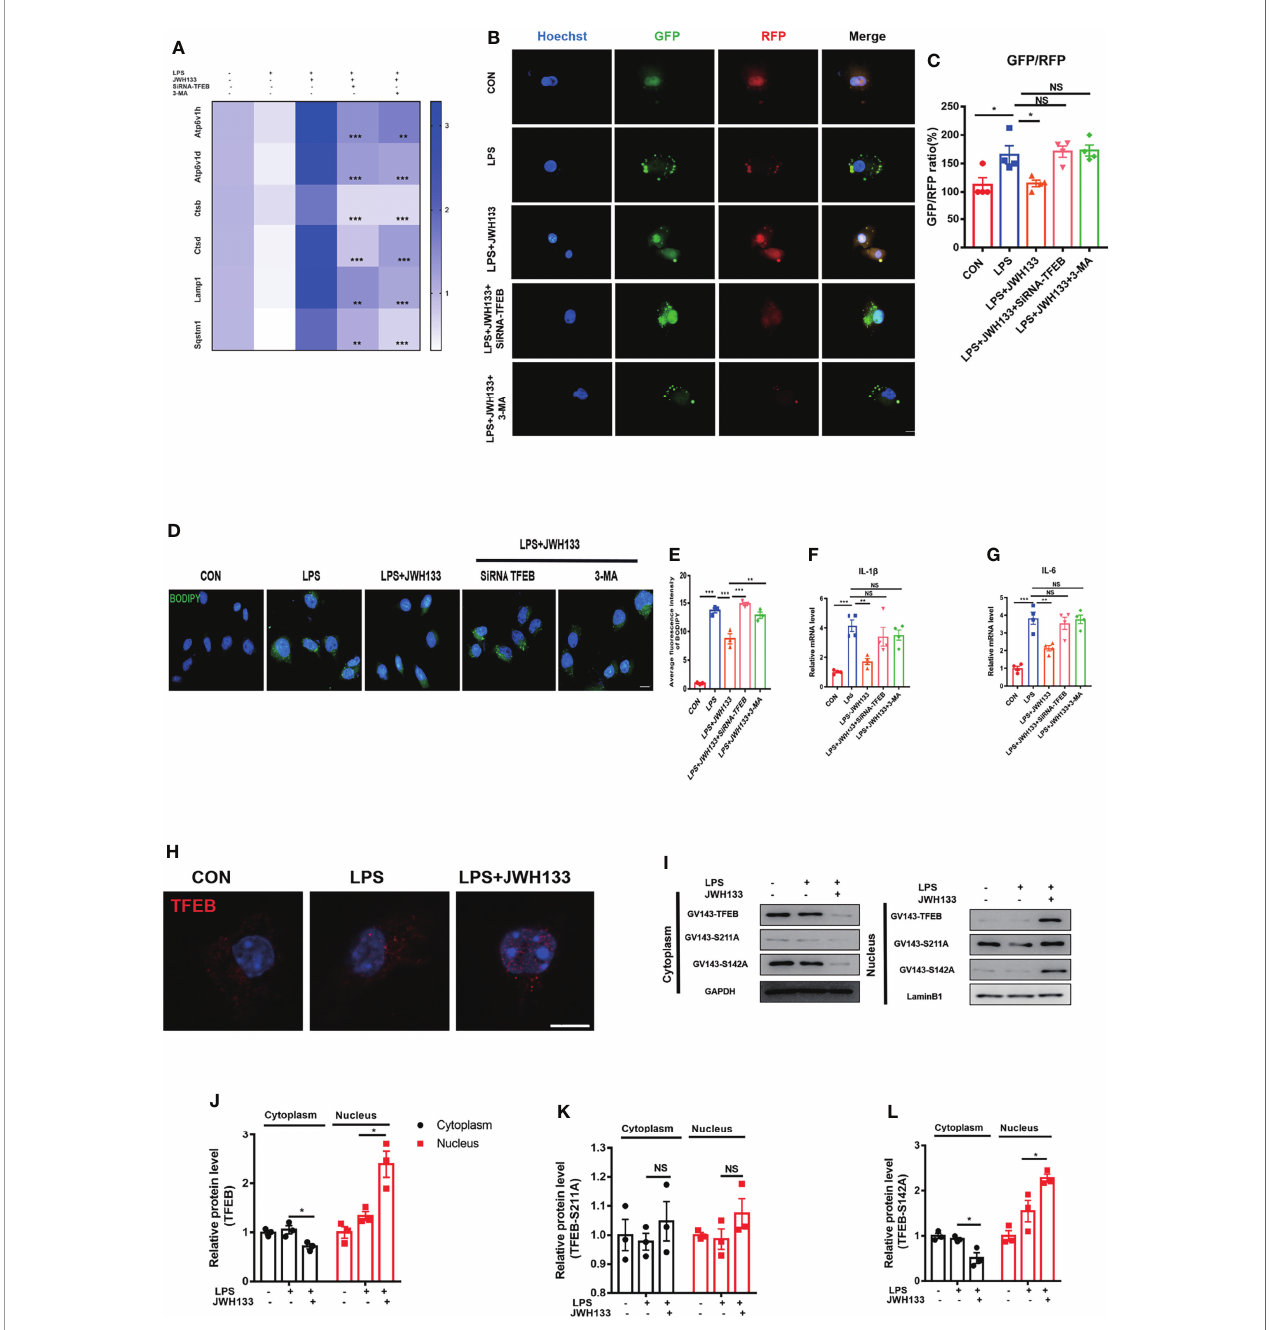
FIGURE 5 | (A) U87 cells incubated with 5 mM of 3-MA and 1 m M of JWH133 for 1 h and then stimulated with 100 ng/mL of LPS for 6 h. U87 cells in the LPS+ JWH133+SiRNA-TFEB group, mediated by SiRNA – TFEB for 48 h before treatment, collected for Q-PCR analysis (Sqstm1, Lamp1, Ctsd, Ctsb, Atp6v1d, Atp6v1h, and LPS+JWH133+SiRNA-TEEB LPS+JWH133+3-MA compared with LPS+JWH133; Statistical difference indicated in the fi gure; means±SEM, for 4 independent experiments). (B, C) U87 cells used in experiments 4 d after infection with the RFP-GFP-MAP1LC3B adenovirus. Cells treated using the same procedure as before. Determination of the relative GFP-to-RFP ratio (for 4 independent experiments, scale bar=20 m m). (D, E) BODIPY staining and statistical data for U87 cells (for 4 independent experiments, scale bar=20 m m). (F, G) Q-PCR analysis of IL-1 b and IL-6 (means±SEM, for 4 independent experiments). (H) U87 cells tested for TFEB expression by using immuno fl uorescence (Scale bar=50 m m). (I – L) Transfection of GV143-TFEB, GV143-S211A, and GV143-S142A plasmids into U87 cells, cytoplasmic nucleoprotein extraction, and Western blot detection. Data shown in the fi gure (means±SEM, for 3 independent experiments). NS means not signi fi cant, * P < 0.05, ** P < 0.01, *** P < 0.001 compared with the corresponding group, as determined by two-way ANOVA, F (2,12) TFEB Interaction =22.83; F (2,12) TFEB -S211A ’ s post hoc Interaction = 0.05; F (2,12) TFEB -S142A Interaction = 24.81, followed by Tukey